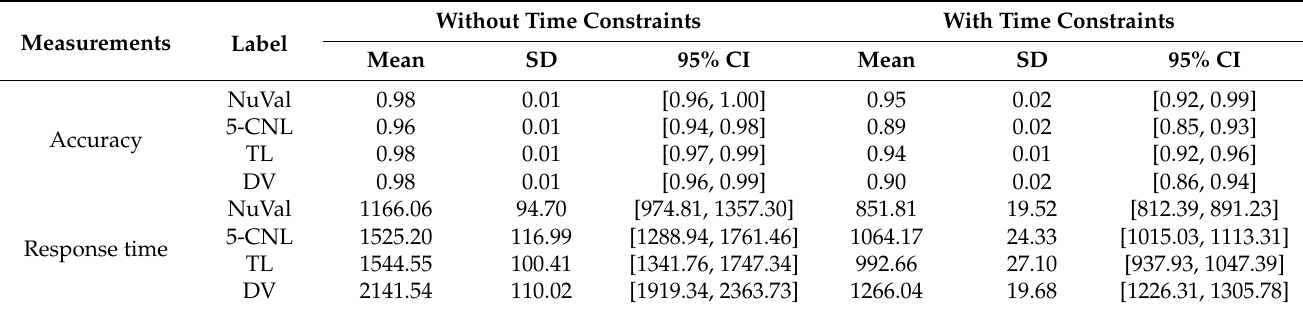
Table 1. Mean accuracy and response time results of nutrition labels in Experiment 1.